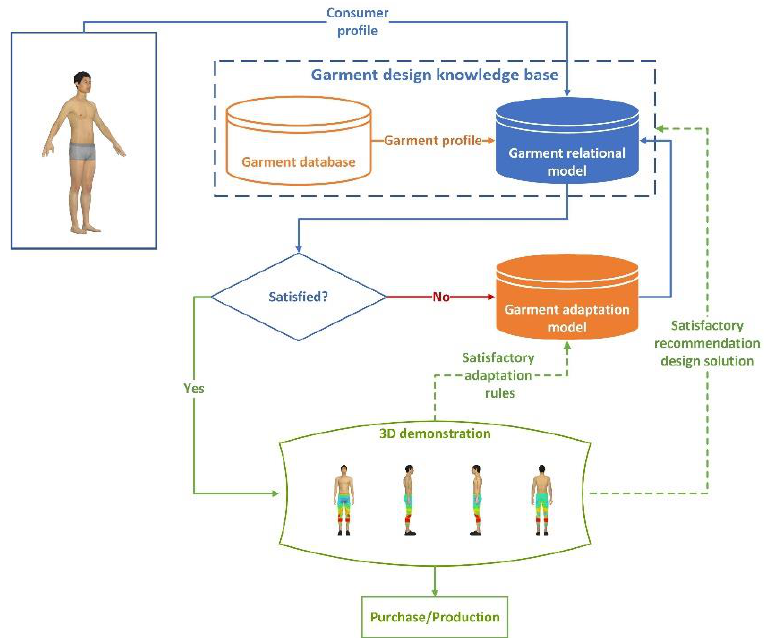
Figure 1. The proposed interactive and personalized garment design recommendation system.